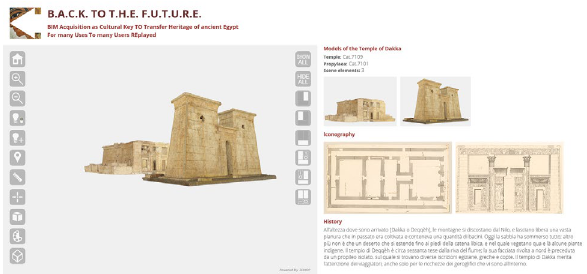
Figure 1. Web portal